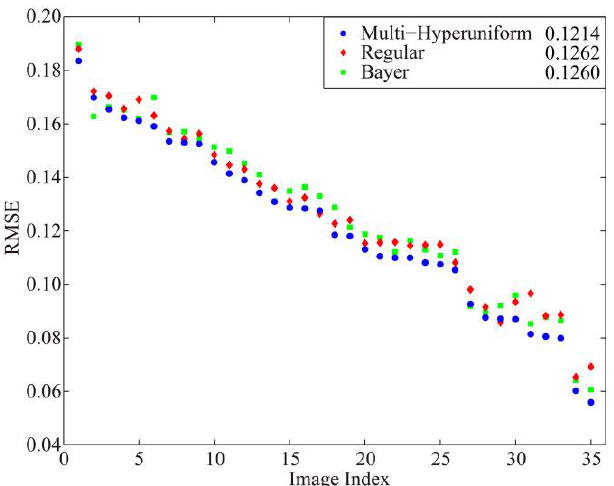
Figure 4. RMSEs of the reconstructed chromatic images using multi-hyperuniform ( blue dot ), regular ( red diamond ), and Bayer ( green square ) sampling patterns. The averaged values of 35 image RMSEs are listed on the label.